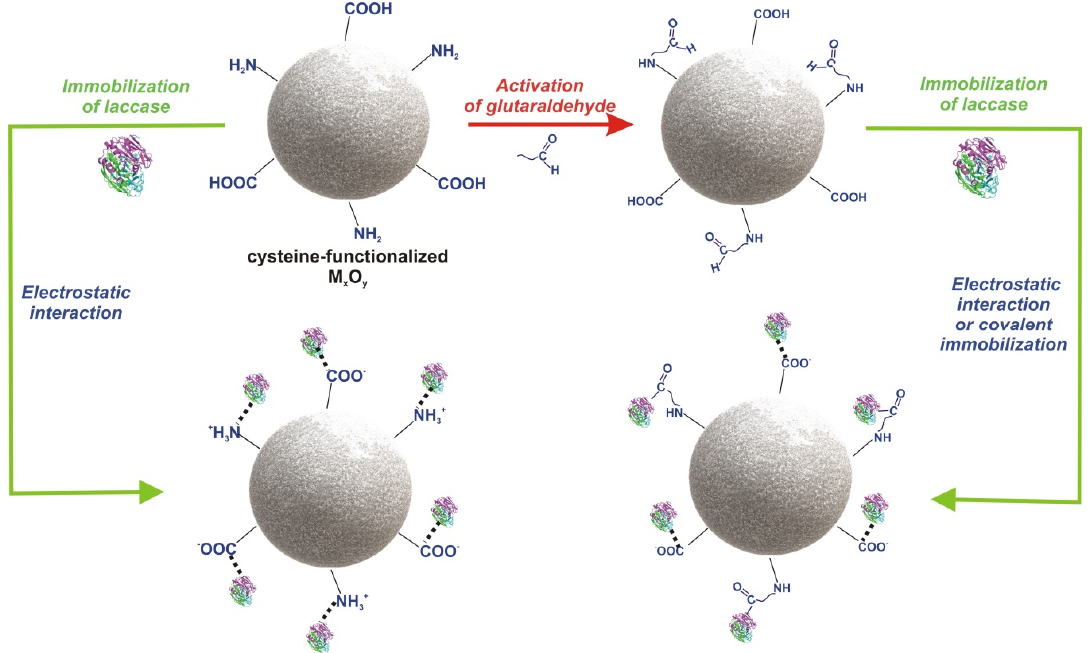
Figure 4. A suggested mechanism of immobilization of laccase onto cysteine-functionalized M x O y .